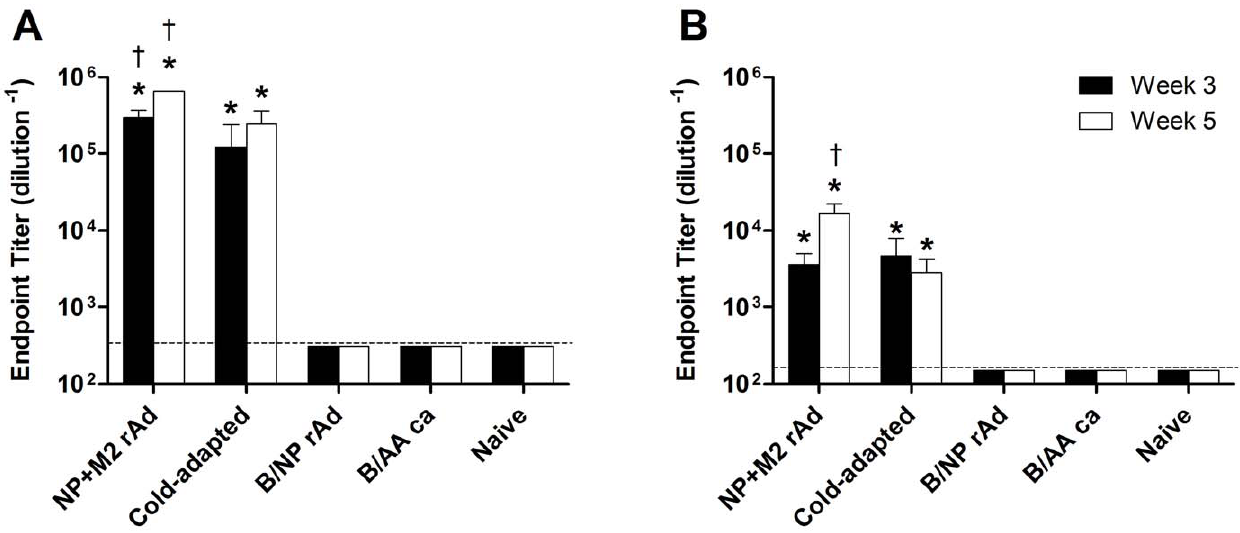
Figure 1. Anti-NP serum antibody titers. Anti-NP IgG levels in the serum of immunized mice at various timepoints following immunization. BALB/c (A) or B6 (B) mice were immunized with 1 6 10 10 TCID 50 of NP + M2-rAd or B/NP rAd, 2 6 10 5 TCID 50 of A/Alaska ca + A/Hong Kong ca (Cold- adapted) or B/AA ca , or left unvaccinated. Serum was obtained at 3 weeks (solid bars) or 5 weeks (open bars) post-vaccination and tested for anti-NP IgG as described in Materials and Methods. Shown are the mean endpoint titers 6 SD; n=5 per group. * P # 0.05 versus naı¨ve, { P # 0.05 versus ca ; One Way ANOVA with Student-Newman-Keuls post-test. doi:10.1371/journal.pone.0021937.g001 PLoS ONE |